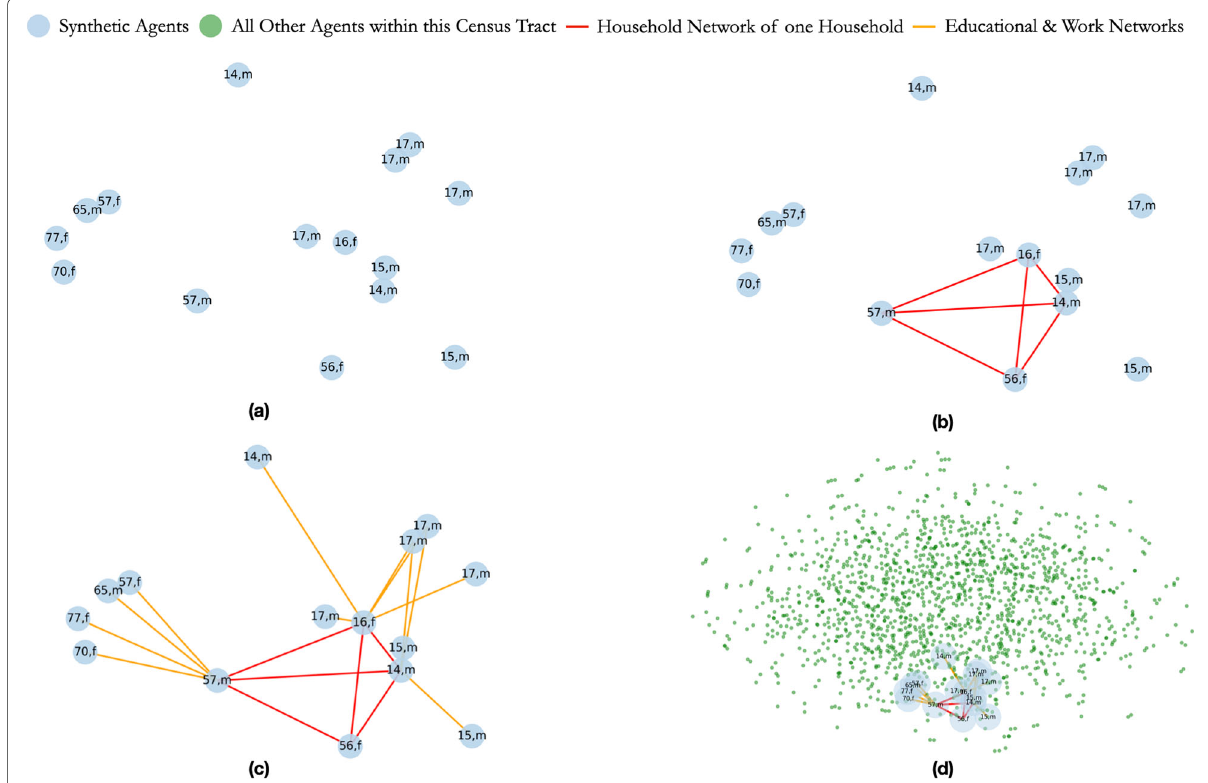
Fig. 4 Creation of Social Networks: ( a ) Selected Population; ( b ) Creation of a Household Network; ( c ) Creation of Work and Educational Networks for each Member of the Household; ( d ) The Household, its Networks within the Full Census